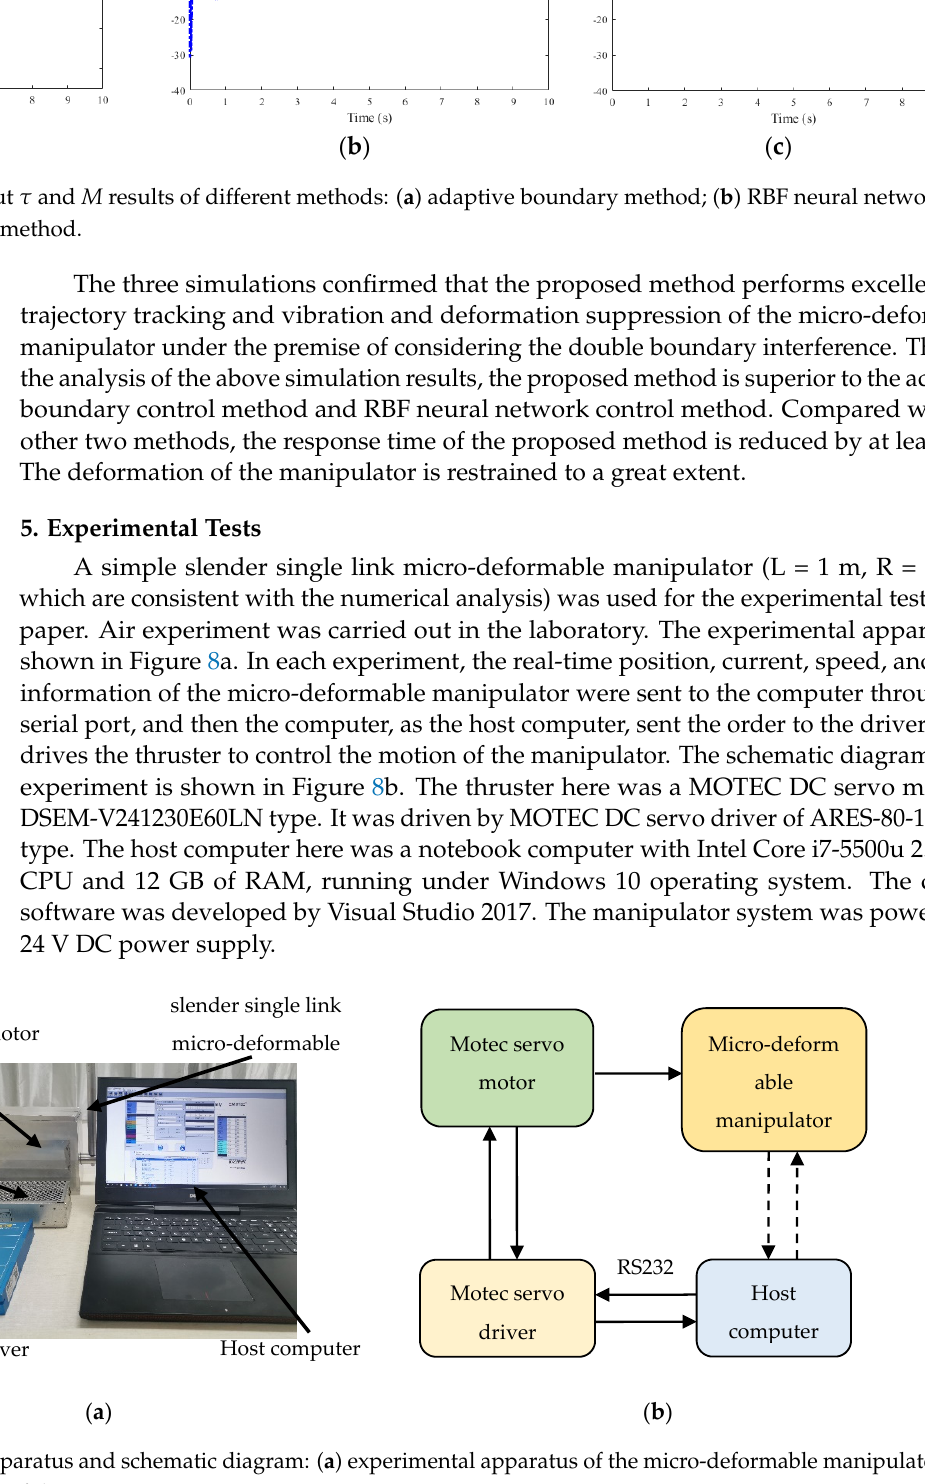
Table 2. The statistical results of the simulation data of the proposed method and the comparison methods.